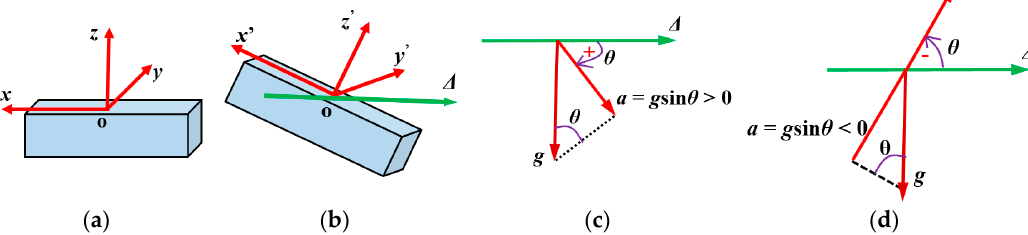
Figure 3. Schematic diagram shows change of accelerometer’s posture, its coordinates, and calculation of acceleration on each axis based on gravitational acceleration and tilt angle. ( a ) Initial position of accelerometer and its coordinate Oxyz. ( b ) Coordinate Ox’y’z’ when accelerometer’s posture changes. ( c ) Acceleration on axis when tilt angle 𝜃 > 0 . ( d ) Acceleration on axis when tilt angle 𝜃 < 0 .